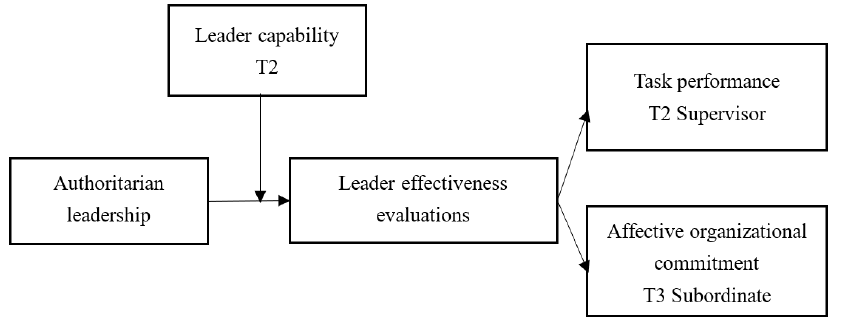
Figure 1. The theoretical model.